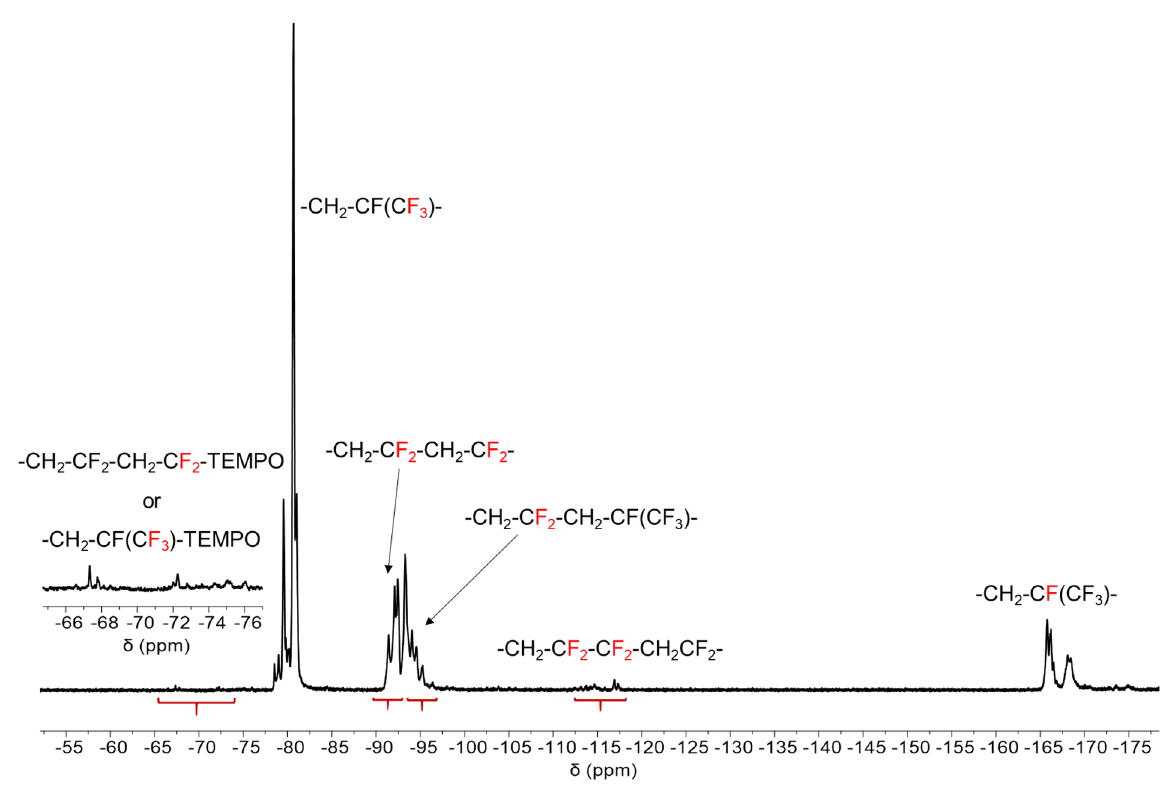
Figure 3. 19 F NMR spectrum recorded in (CD 3 ) 2 CO of P(VDF- co -1234yf) copolymer synthesized via OMRP at 60 °C (Table 1, Entry 8). Table 1. Results on the kinetics of the copolymerization of VDF with 1234yf via OMRP. Conditions